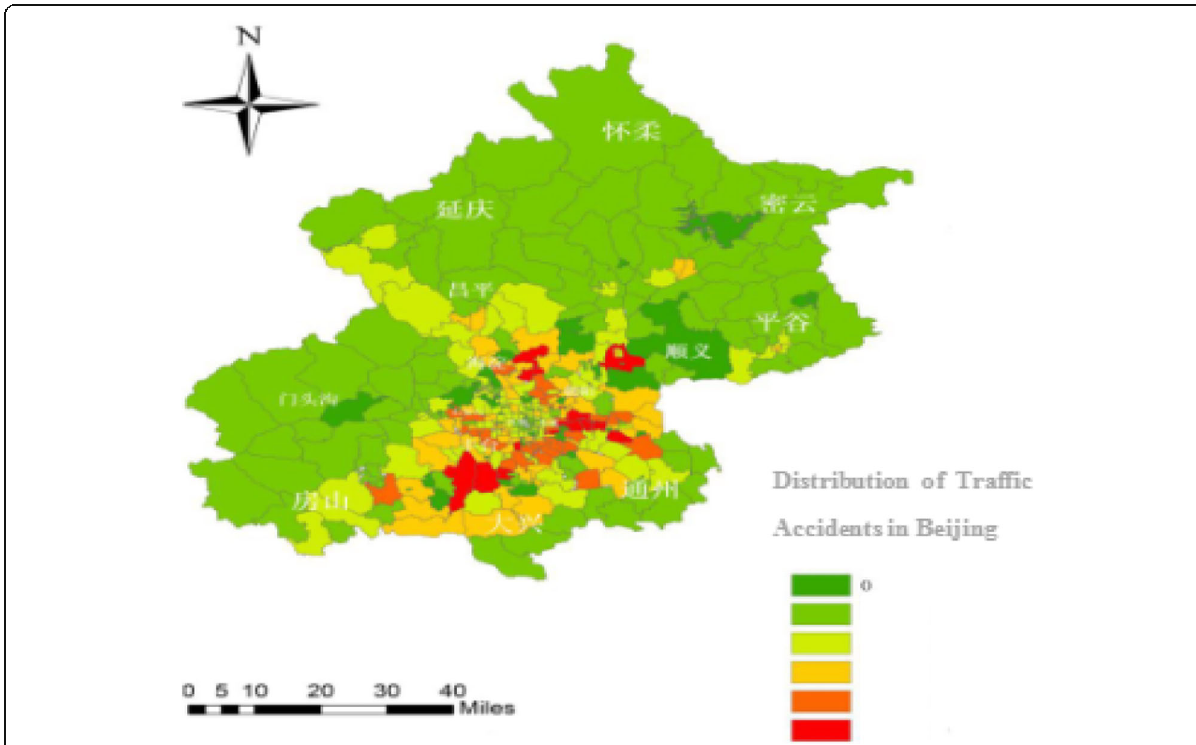
Fig. 10 Spatial distribution of traffic accidents in Beijing